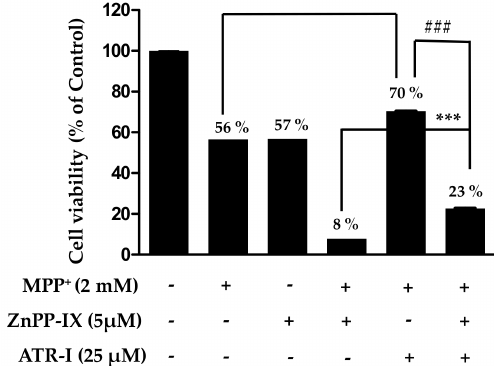
Figure 5. SH-SY5Y cells were pre-incubated with or without zinc protoporphyrin-IX (ZnPP-IX ) (5 µ M) for 2 h before treating them with ATR (25 µ M) for another 2 h. Cells were further exposed to 2 mM MPP + for 24 h. Cell viability was measured by MTT assay. $$$ p < 0.001 vs. the MPP + group, ### p < 0.001 vs. the MPP + + ATR-I group and *** p < 0.001 vs. the ZnPP-IX + MPP + -treated